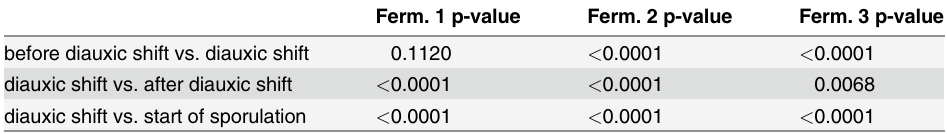
Table 3. Comparison of the specific stages of bacterial growth by Mann-Whitney U test.